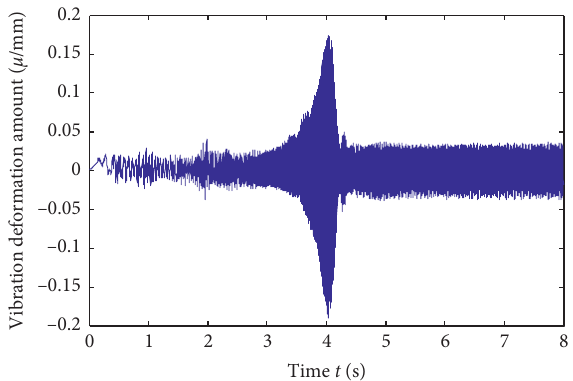
Figure 15: Support’s positions 40mm, 0 mm, −